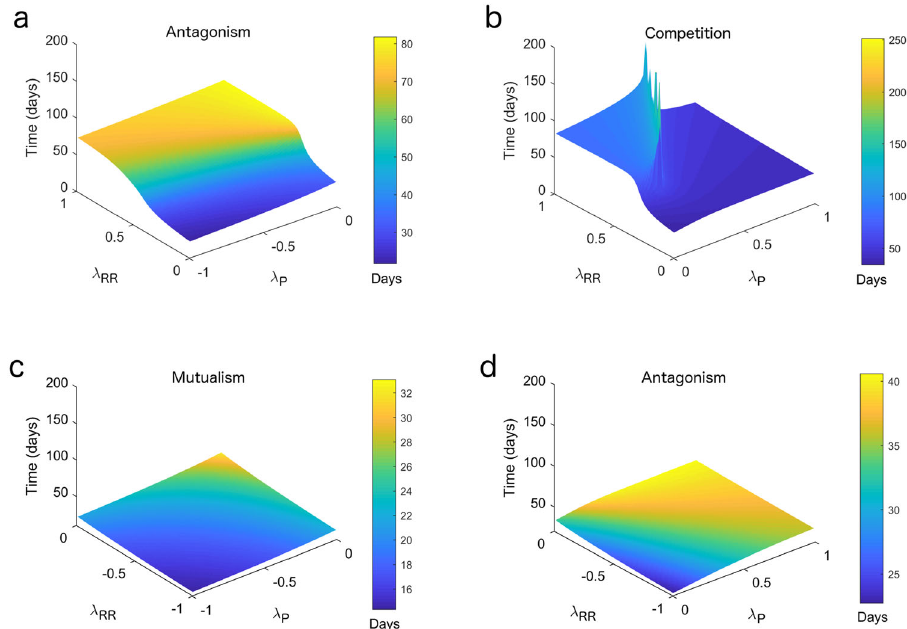
Fig. 5 The type of ecological interaction alters regrowth time after radiation. a – d For each type of ecological interaction (i.e., antagonism, competition, and mutualism), mixed spheroids were grown in silico using a range of interaction parameters λ P and λ RR until the volume reached 0.9 mm 3 . At this volume, spheroids were irradiated (6 Gy) in silico and monitored for regrowth until they reached 0.9 mm 3 . Radiation damage was simulated using the linear- quadratic model, for which input values ( α and β ) were determined from experimental PC3 clonogenic assays: parental population, α = 0.44 ± 0.07 and β = 0.04 ± 0.01; radioresistant population, α = 0.35 ± 0.06 and β = 0.03 ± 0.01. The numbers of parental and radioresistant cells at the time of radiation depend on the values of λ P and λ RR , whereas the numbers post-radiation depend on the effect of radiation on each population, and on the values of λ P and λ RR . See Supplementary Methods section 1 for more details on the mathematical